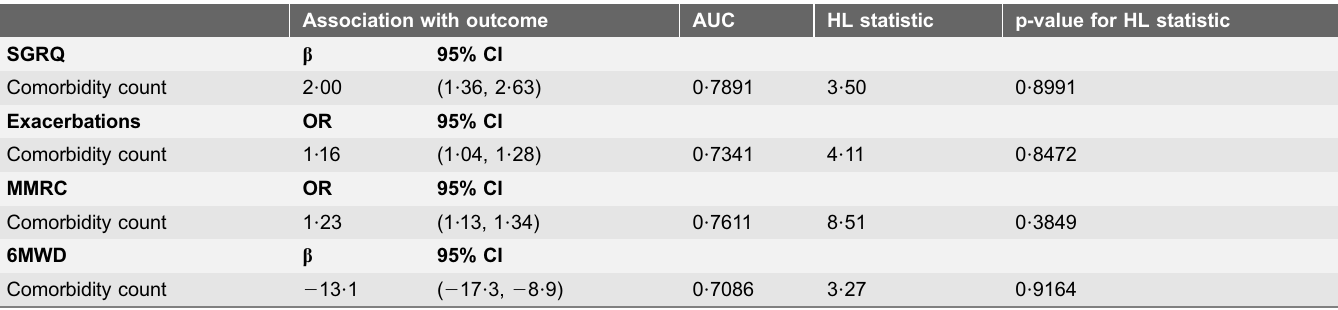
Table 4. Discrimination measures (AUC) and calibration measures (Hosmer-Lemeshow calibration statistics) for comorbidity count with regards to outcomes of exacerbations, MMRC, and 6MWD, in the SPIROMICS participants.